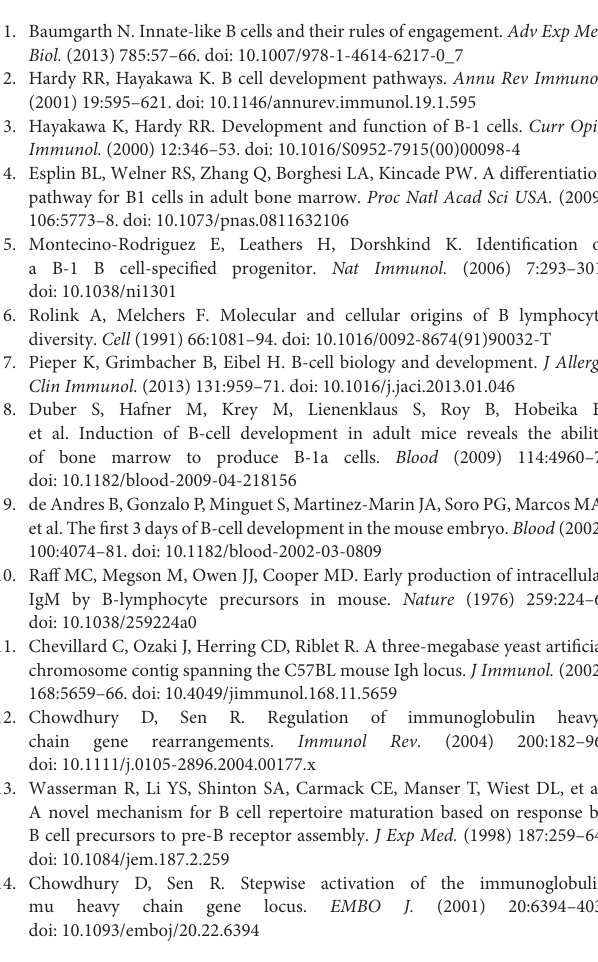
correspond to the best model according to Akaike’s information criterion. (A) . Frequencies of indicated B cell developmental stages based on data from Figure 1A were used and fitted by least square statistics. (B) . Data from Figure 1B were used and fitted by least square statistics. Supplementary Figure S3 | Gating strategy for mature B cells. Shown is a representative staining for cells isolated from spleen of an induced B-Indu-Rag1 mouse. Cells were gated for lymphocytes first using forward and sideward scatter. Doublets were excluded by applying FSC area and heights against each other. Dead cells were excluded by gating for DAPI-negative cells. Those cells were then gated for CD19 and furthermore classified according to the figure and CD23, CD21, CD5 expression. Supplementary Figure S4 | Gating strategy for peritoneal mature B cell populations. Shown is a representative staining for cells isolated from peritoneal cavity of an induced B-Indu-Rag1 mouse. Cells were gated for lymphocytes first using forward and sideward scatter. Doublets were excluded by applying FSC area and heights against each other. Dead cells were excluded by gating for DAPI-negative cells. Cells were further subdivided based on their expression of CD19, CD43, Mac-1 (CD11b), and CD5. Supplementary Figure S5 | Results of least squares fitting for mature B cells. Analysis was carried out like for Figure S2 . Frequencies of indicated BCR + B cell subsets based on data from Figure 2 were used and fitted by least square